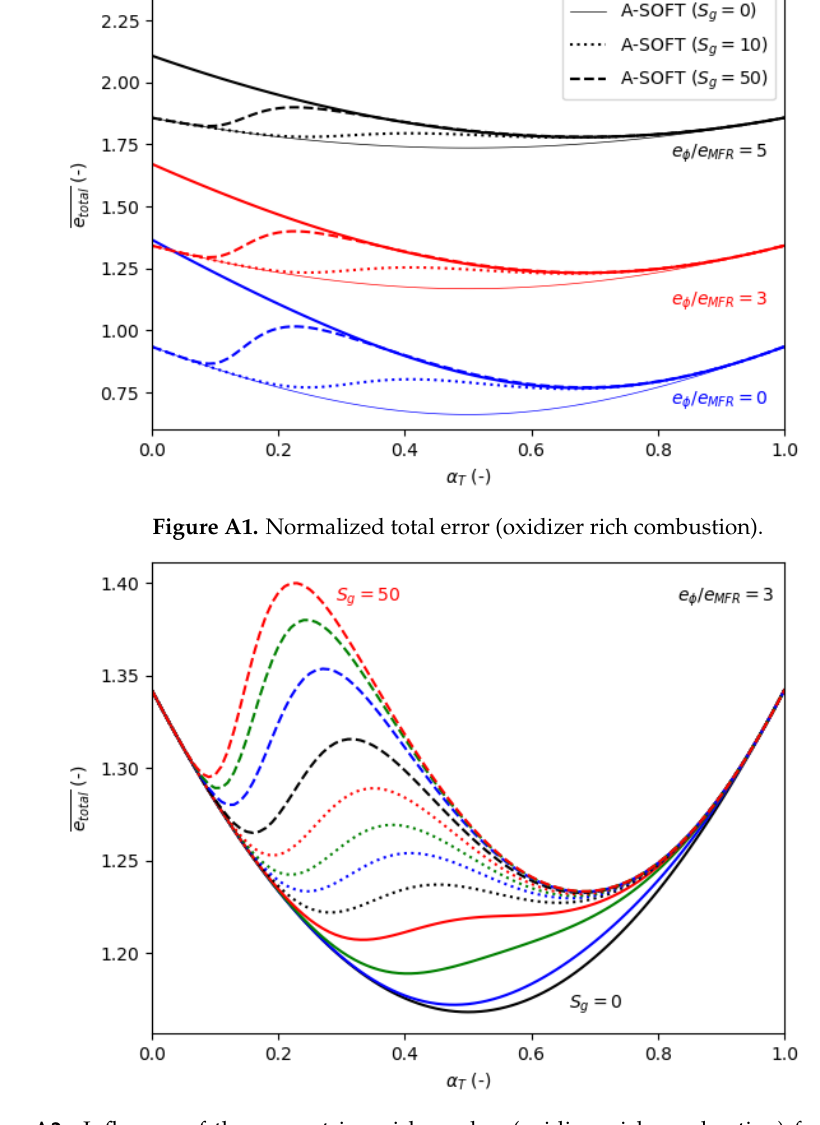
Figure A2. Influence of the geometric swirl number (oxidizer rich combustion) for S g values in